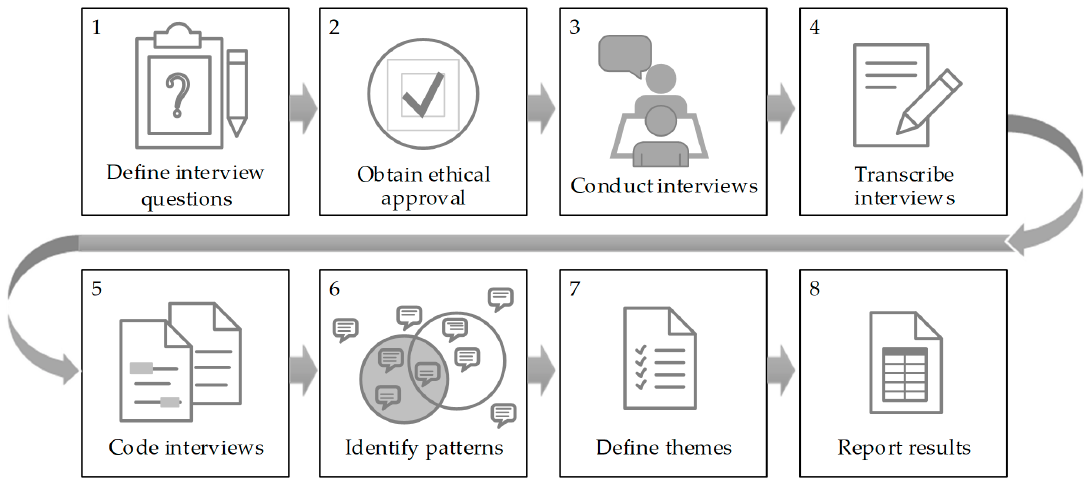
Figure 2. The qualitative methodology used in the current research.